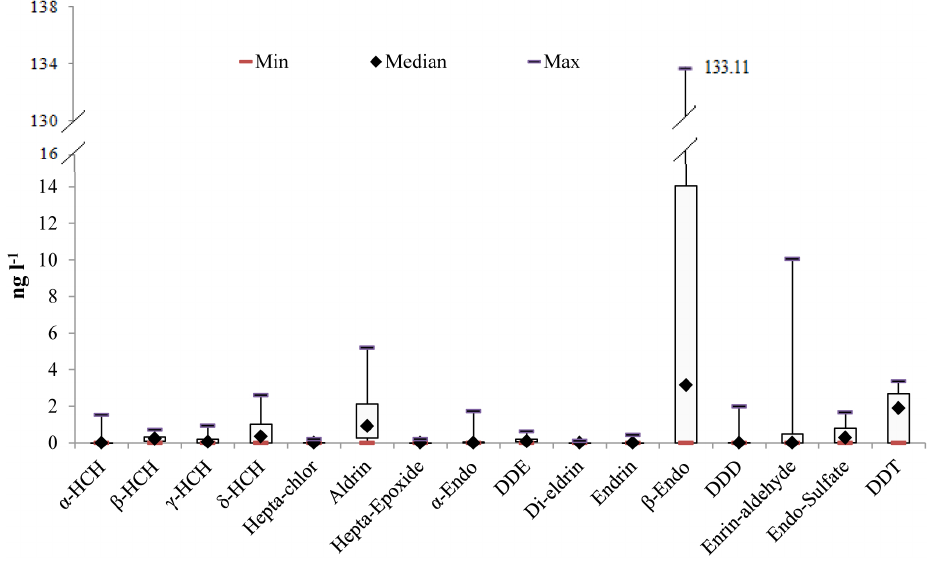
Figure 5. Organochlorine residues (ngL − 1 ) in water matrices of rivers of Uttar Pradesh (UP).